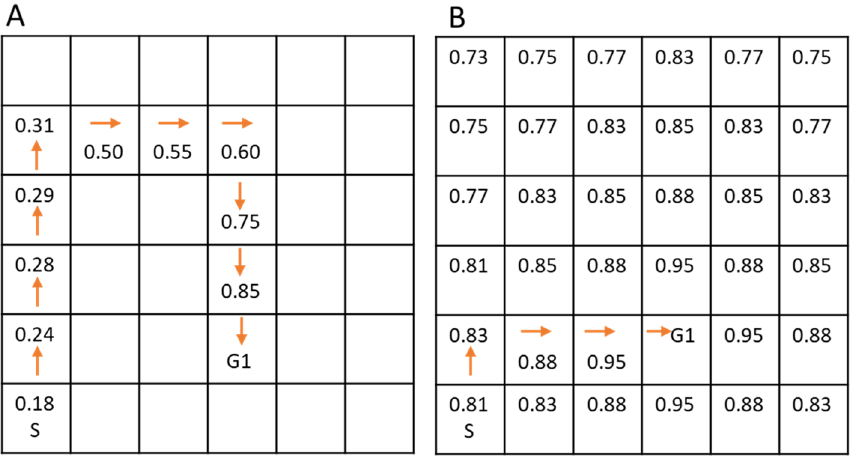
Figure 2. Model-free ( A ) and model-based ( B ) reinforcement learning models. The numbers in the figure are state values, showing how a navigator decides to move along the route in a given state/room. ( A ) Model-free valuation based on the TD algorithm. After finding an object this algorithm updates the values only along the traversed path. ( B ) Model-based valuations derived from dynamic programming. The model-based algorithm assumes a perfect cognitive map and the values in the entire environment are precomputed (See Model-based reinforcement learning). S starting location, G1 Goal object # 1.